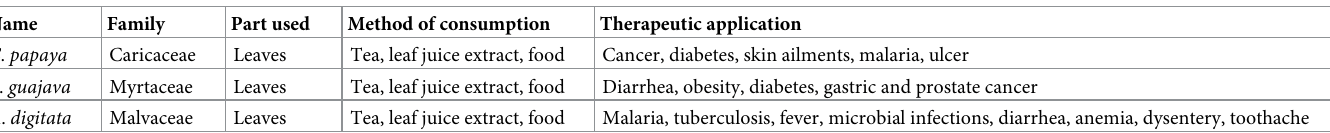
Table 1. Therapeutic application of the three herb extracts in Nigeria